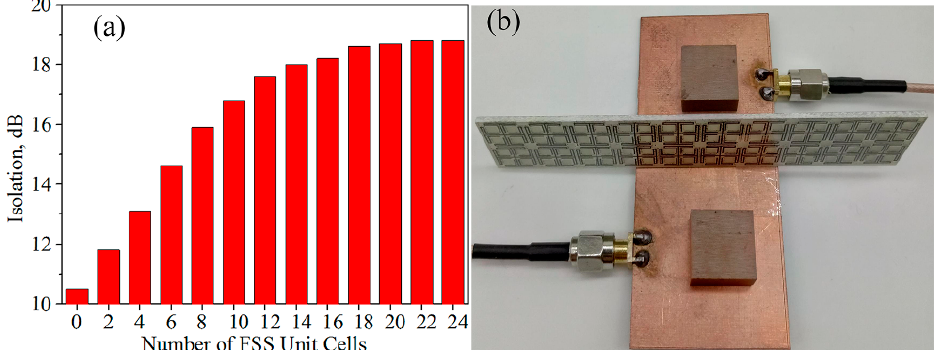
Figure 9. Measurement about the number of FSS unit cells. ( a ) Isolation versus the number of FSS unit cells at 3.5 GHz. ( b ) The prototype of the DRAs array.